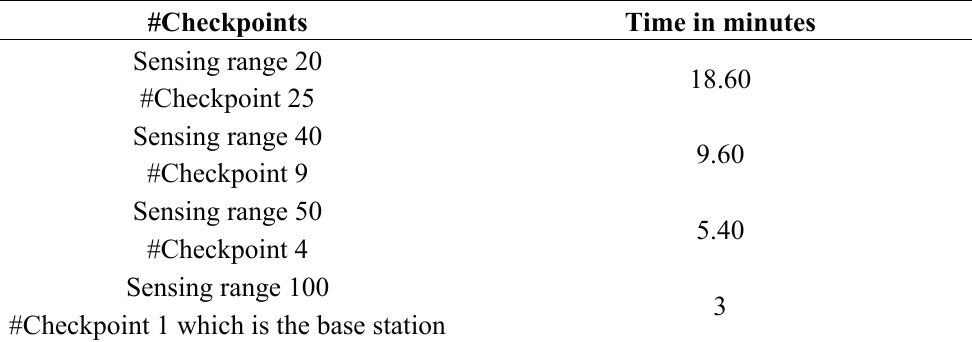
Table 5 Simulation results for one round